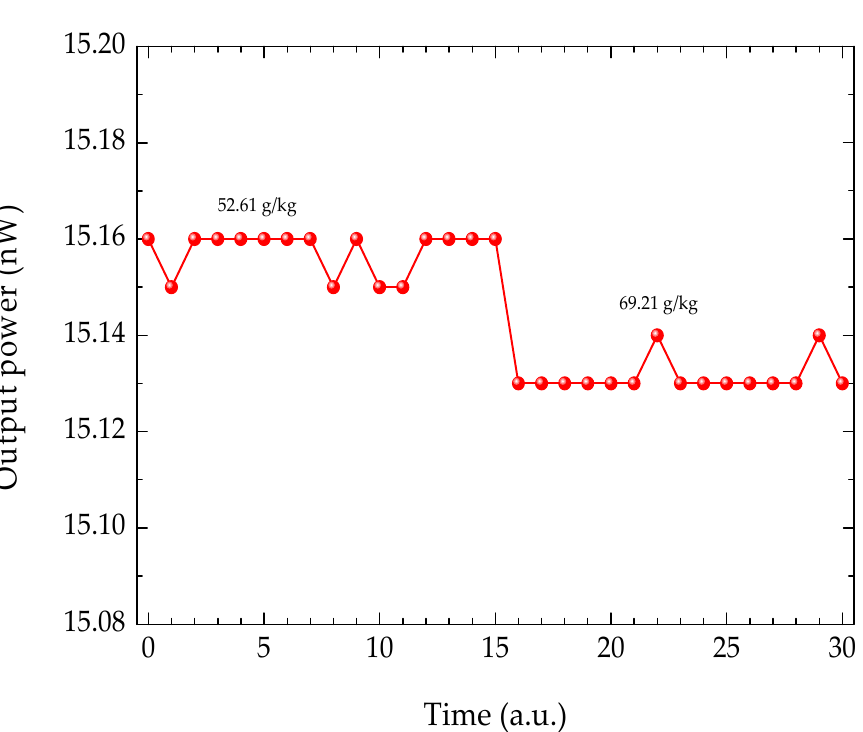
Figure 7. Step technique to estimate the sensing head resolution. The reference port was immersed in the reference solution (40% ethanol and 60% deionized water) and the sensing head was immersed, consecutively, in paracetamol samples with consecutive values of concentration, 52.61 g/kg and 69.21 g/kg, respectively.